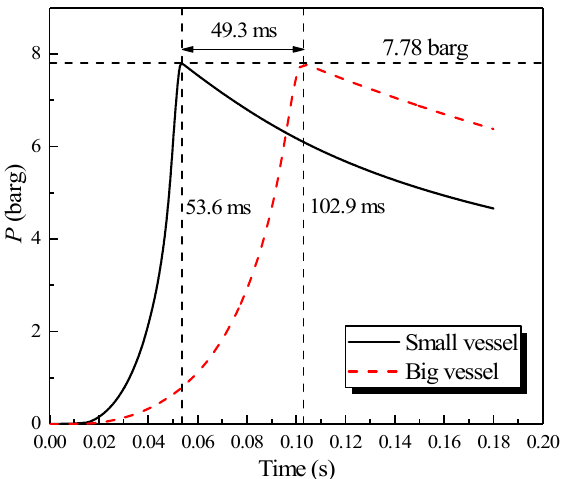
Figure 3. Natural gas explosion pressure varying with time in two single vessels.